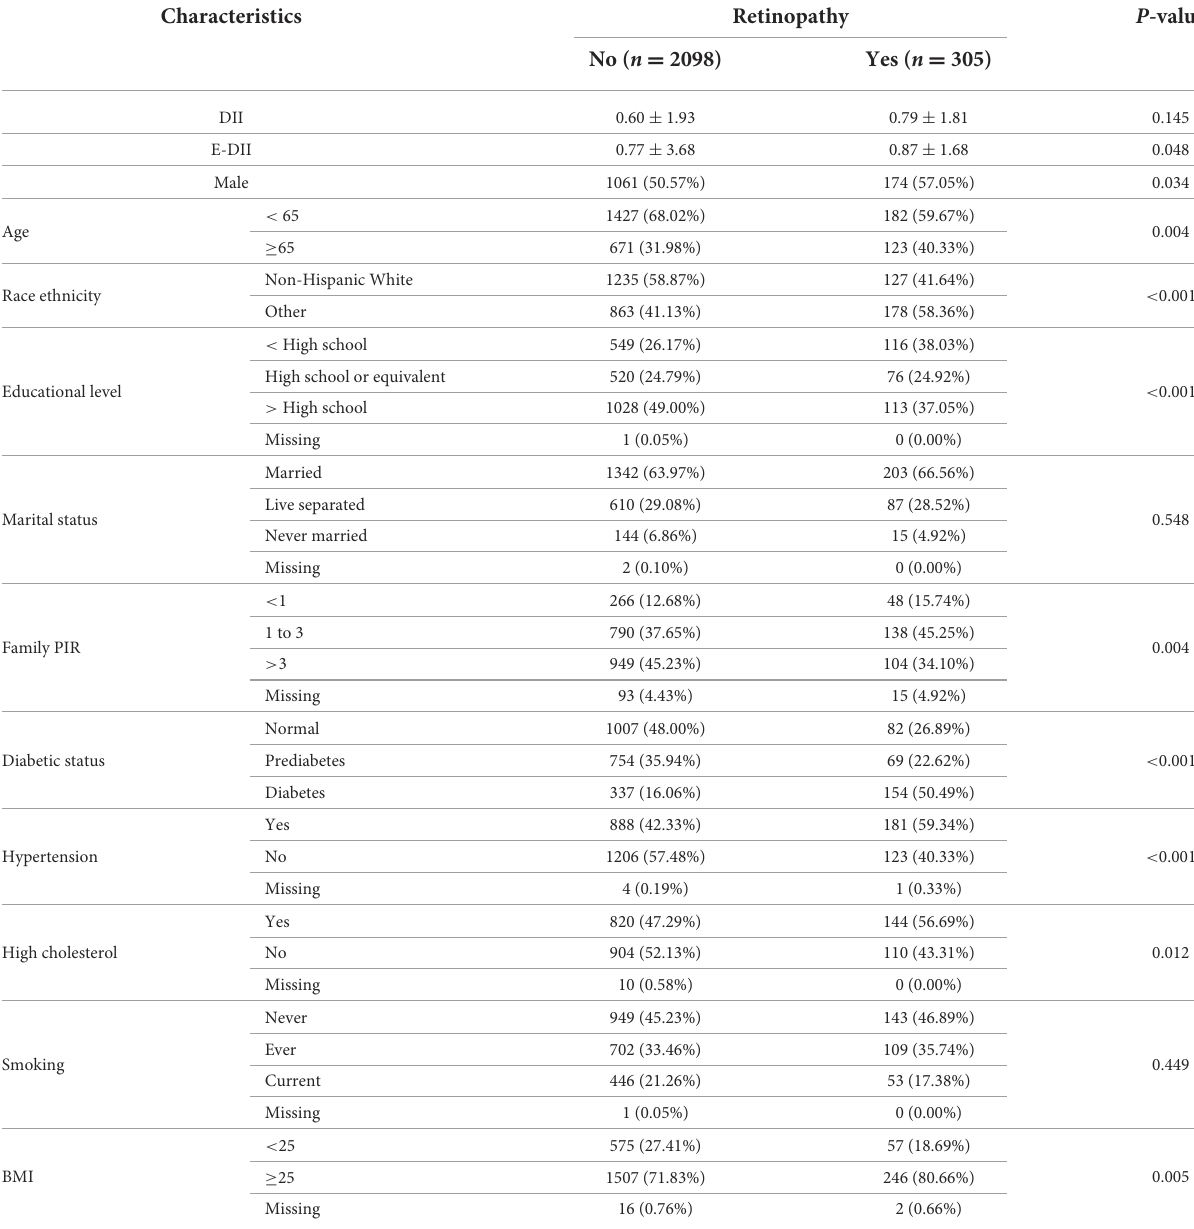
TABLE 1 Baseline characteristics of participants in the 2005–2008